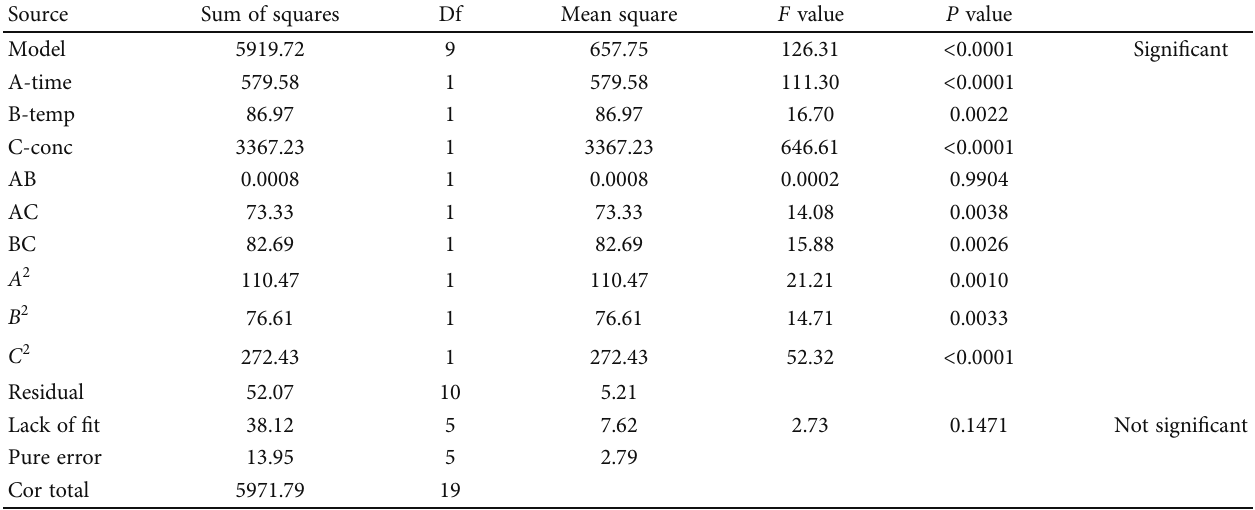
Table 5: Analysis of variance (ANOVA) for response for prede fi ned model for the experimental results.